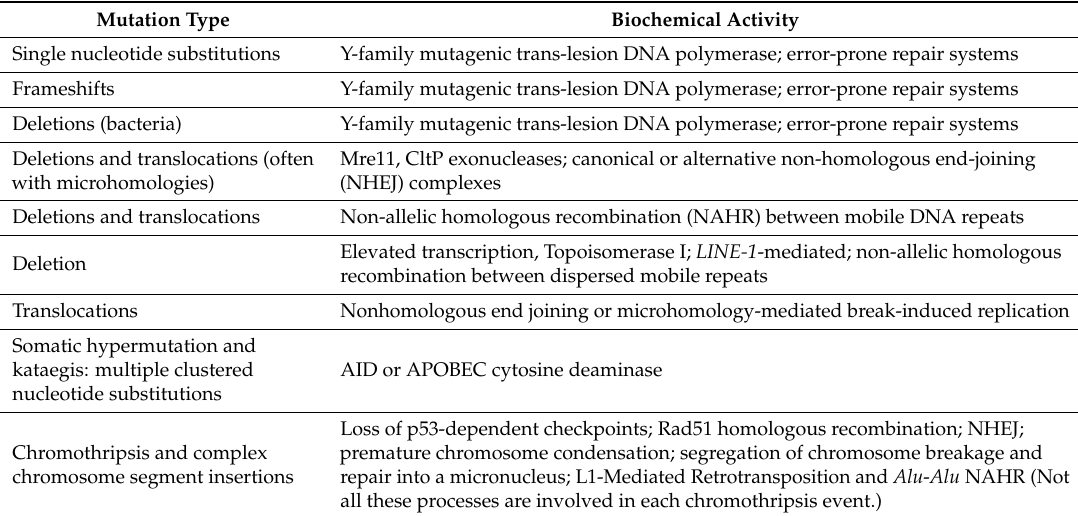
Table 15. Diverse Mutagenic Natural Genetic Engineering Outcomes.